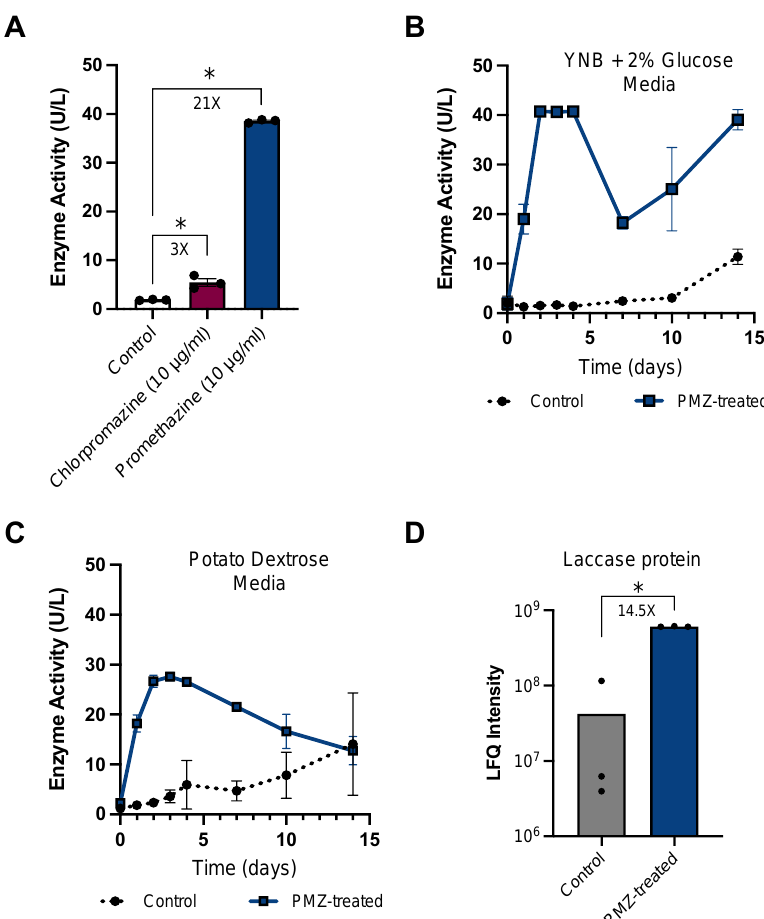
Figure 2. P. radiata laccase activity in response to promethazine treatment. ( A ) Scale-up laccase activity assays of P. radiata conditioned media after treatment with the top two phenothiazine compounds identified in the chemical screen: chlorpromazine and promethazine. P. radiata mycelia were grown in 20 mL YNB + 2% glucose and laccase activity was measured using ABTS oxidation assays at 2 days post treatment. Bars represent the mean of n = 3 biological replicates, and error bars represent the standard error of the mean. ( B ) Time course analysis of laccase activity in response to promethazine when P. radiata mycelia were cultured in YNB + 2% glucose or in ( C ) PD media. Each data point represents the mean of 2 biological replicates, and error bars depict standard deviation. ( D ) Quantification of laccase protein detected in P. radiata media supernatants 2 days post promethazine treatment using label-free quantitative proteomics analysis. Bars represent the mean of n = 3 biological replicates and individual data points are shown. Statistical significance is this figure is denoted by * for p < 0.01.